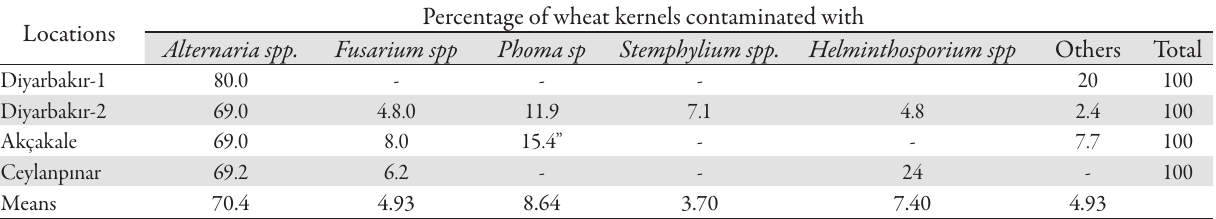
Tab. 4. The incidence of fungi detected by black pointed kernels of four locations in 2000 and 2001 Percentage of wheat kernels contaminated with Locations Alternaria